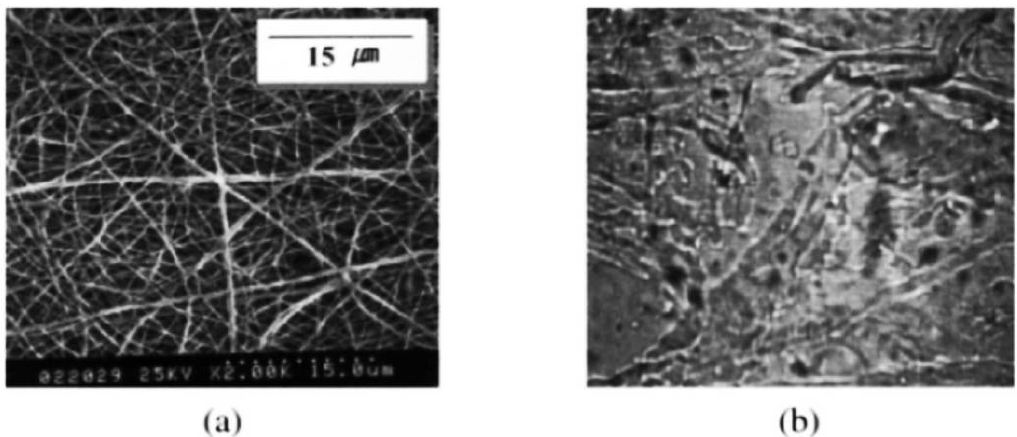
Figure 2. SEM image of PU electrospun fibers ( a ) and the Tegaderm™ wound dressing ( b ). Reprinted by permission from John Wiley and Sons: Journal of Biomedical Materials Research reference [61] Copyright 2003.